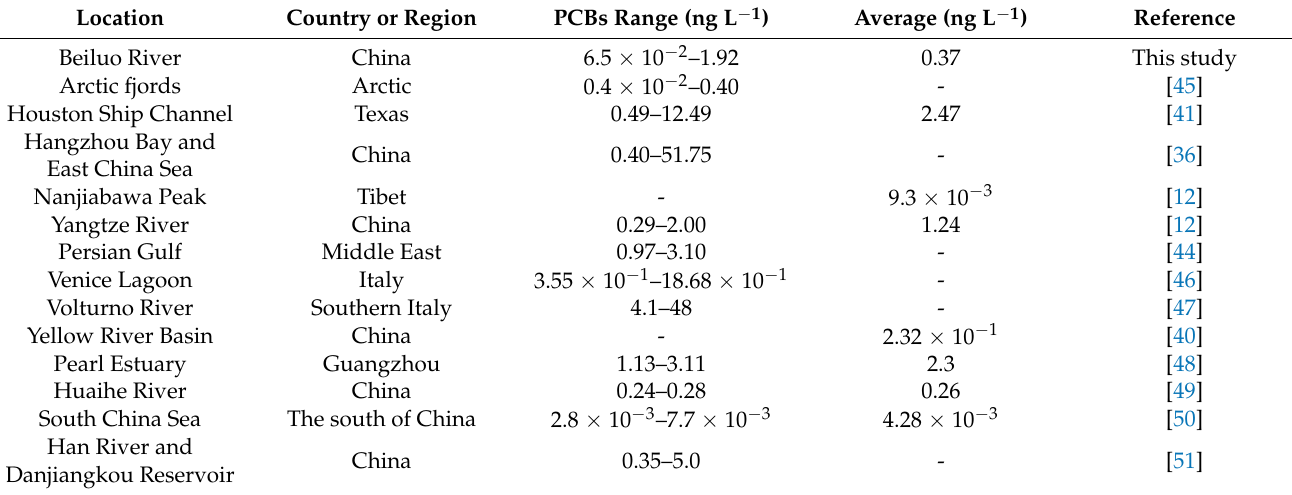
Table 1. Concentrations of PCBs in waterbodies in different regions.